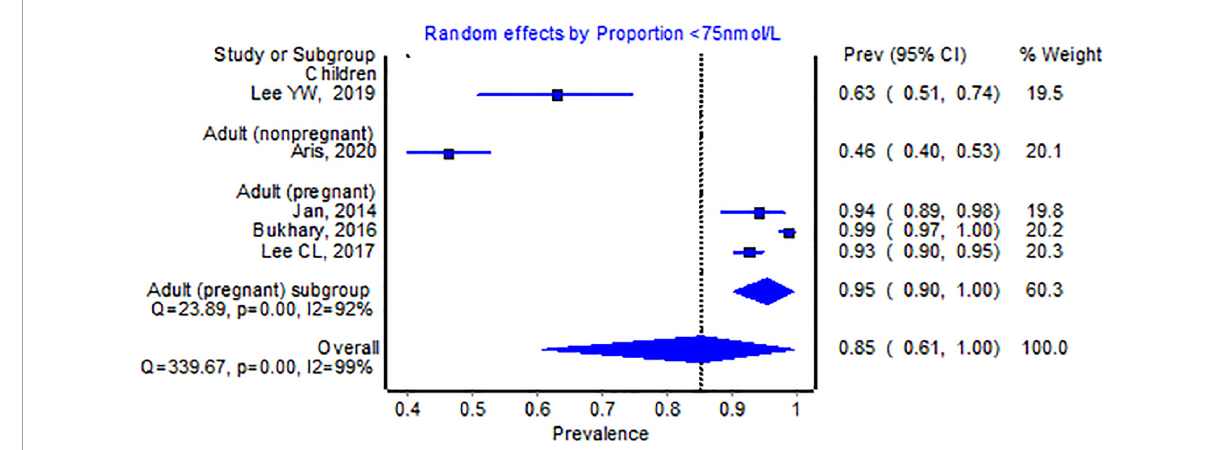
FIGURE4 Pooled proportion of the < 75 nmol/L 25-hydroxyvitamin D cut-off.